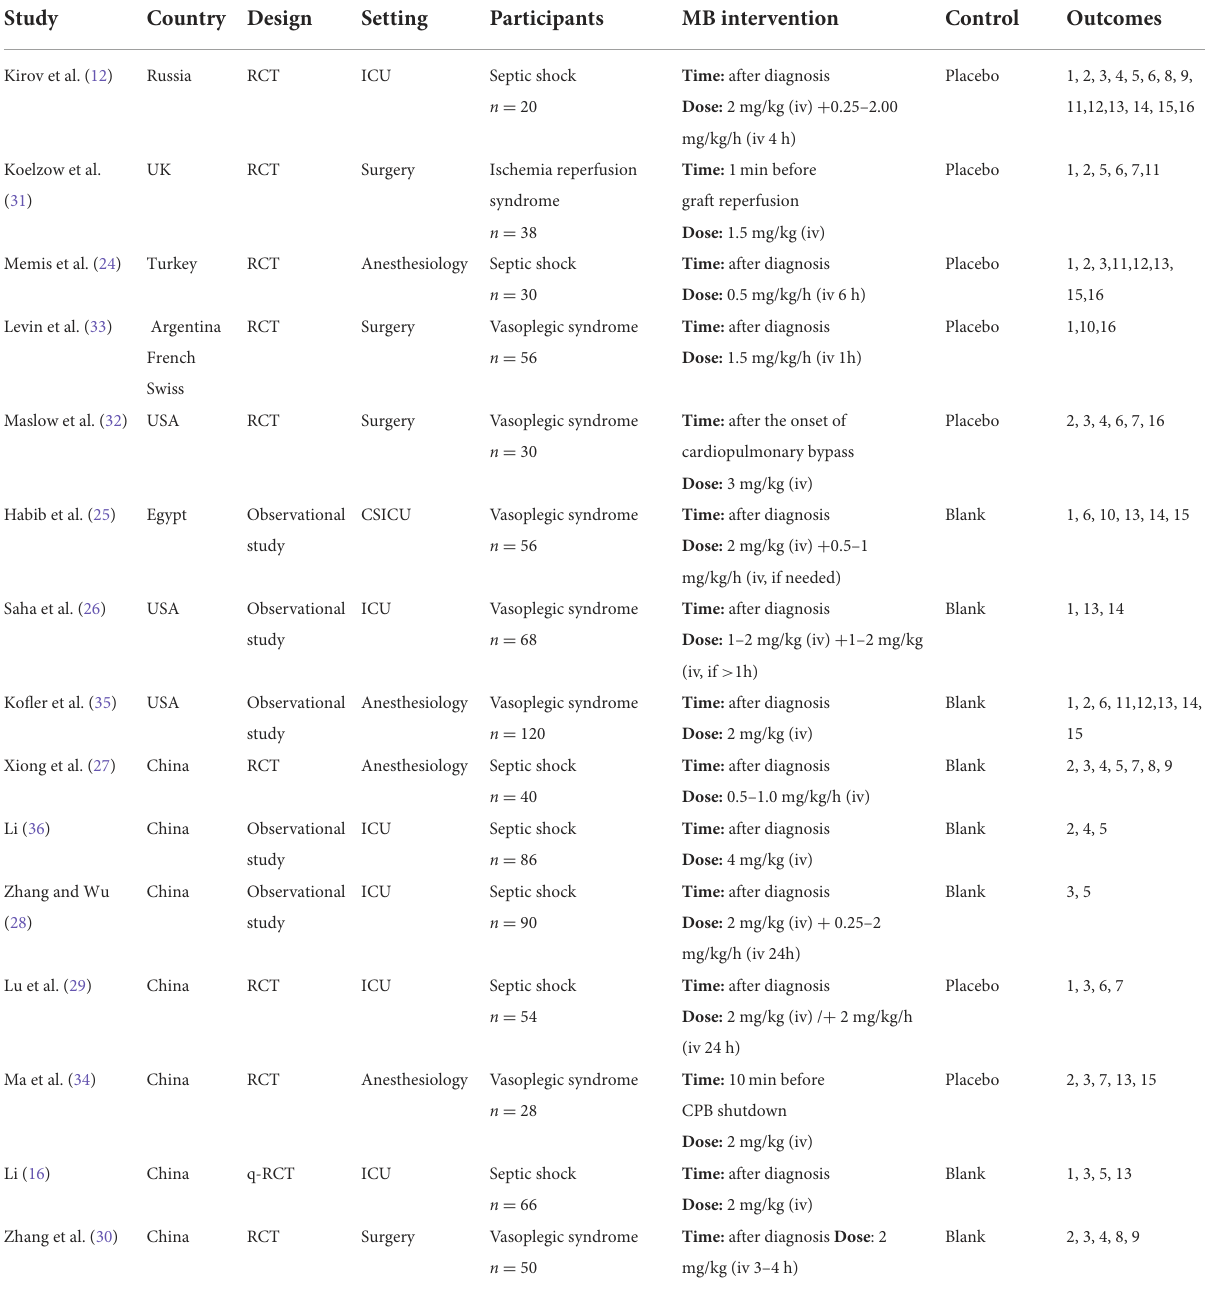
TABLE 1 Characteristics of included